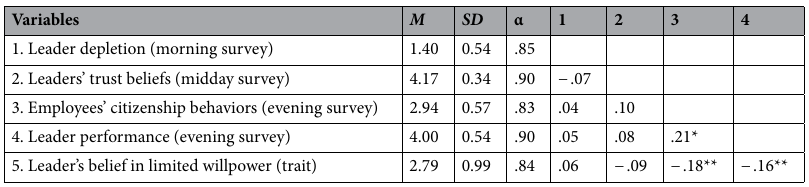
Table 5. Means, standard deviations, and intercorrelations (Study 3). Level-1 relationships are based on group-mean centered variables. Level-1 variables were aggregated when estimating between-individual (Level-